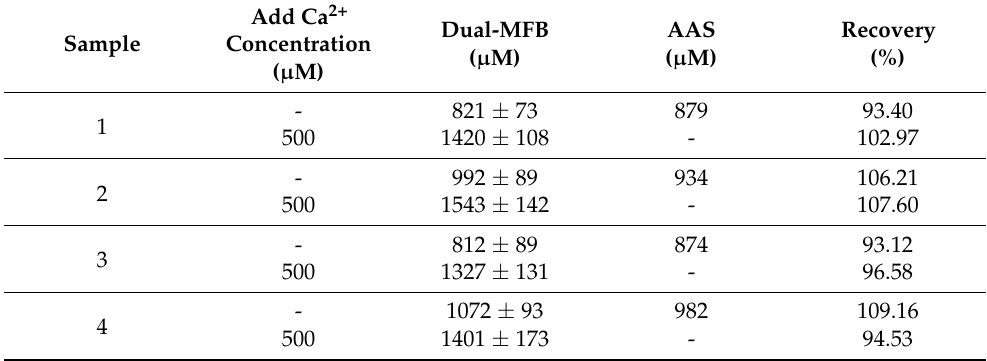
Figure 3. ( A ) Relative resistance of SPFET/SWNTs-PCA/DNAzyme and SPFET/SWNTs- PCA/Nonzyme for different Ca 2+ concentrations in the range of 25 μ M to 100 mM; ( B ) the linear relationship of the relative resistance and the logarithm of the Ca 2+ concentration. Table 2. Ca 2+ concentrations in the actual samples determined by Dual-MFB and